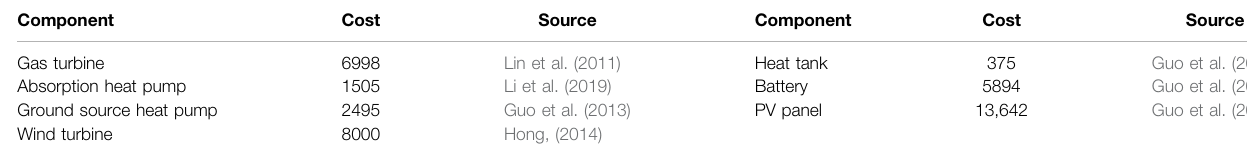
TABLE 2 | Investment costs (Yuan/kW or Yuan/kWh) Component